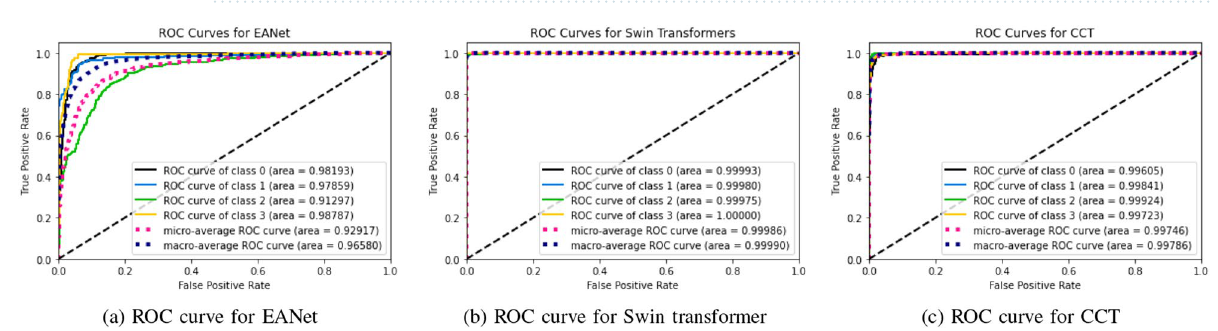
Figure 11. Confusion Matrices for Transfer Based Models Used in Our study.